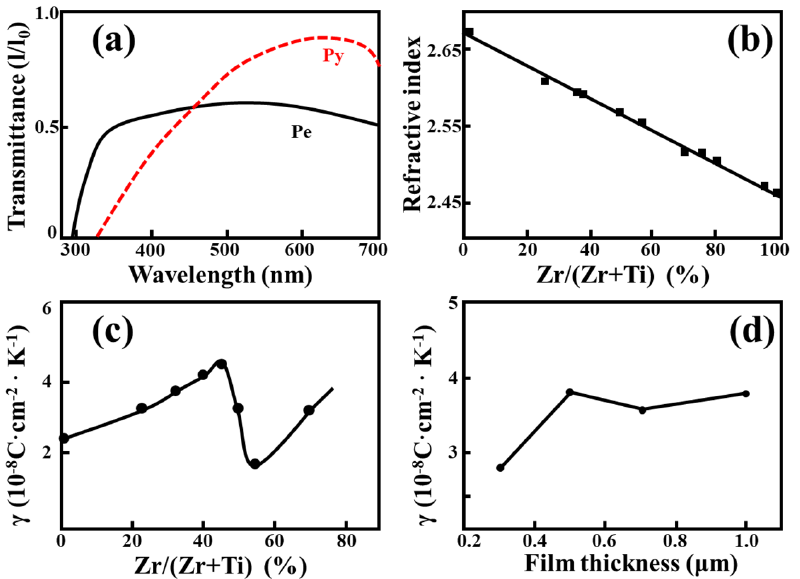
Figure 11. ( a ) Optical absorption spectroscopies of PZT thin films with perovskite and pyrochlore structure. Reprinted with permission from [41] Copyright 1977 AIP Publishing; ( b ) variation of optical indexes of refraction (632.8 nm) with composition for PZT thin films. Reprinted with permission from [82] Copyright 1997 AIP Publishing; ( c ) dependence of film composition on pyroelectric coefficient γ . Reprinted with permission from [84] Copyright 1989 AIP Publishing; ( d ) Influences of film thickness on γ . Reprinted with permission from [85] Copyright 2003 The Physical Society of Japan and The Japan Society of Applied Physics.